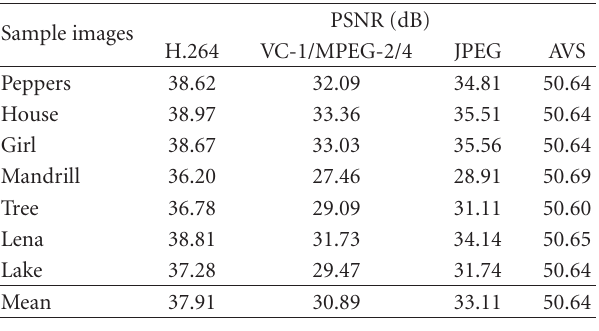
Table 7: Performance measure using standard images for di ff erent standards.